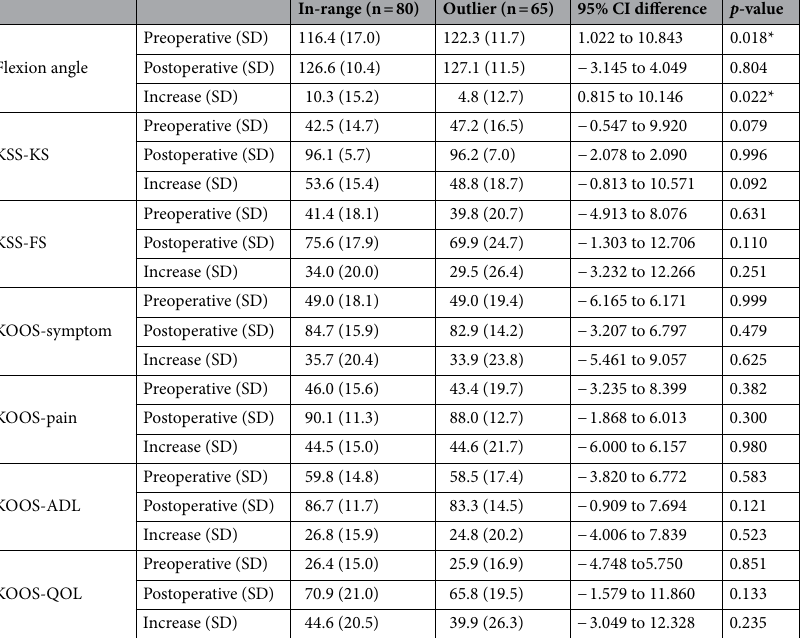
Table 3. Comparison of clinical and patient-reported outcomes between groups for the JLOA. JLOA, joint line orientation angle; KSS, Knee Society Score; KS, Knee Score; FS, Function Score; KOOS, Knee injury Osteoarthritis Outcome Score; SD, standard deviation; CI, confidence interval. *Significant difference, p < 0.05.